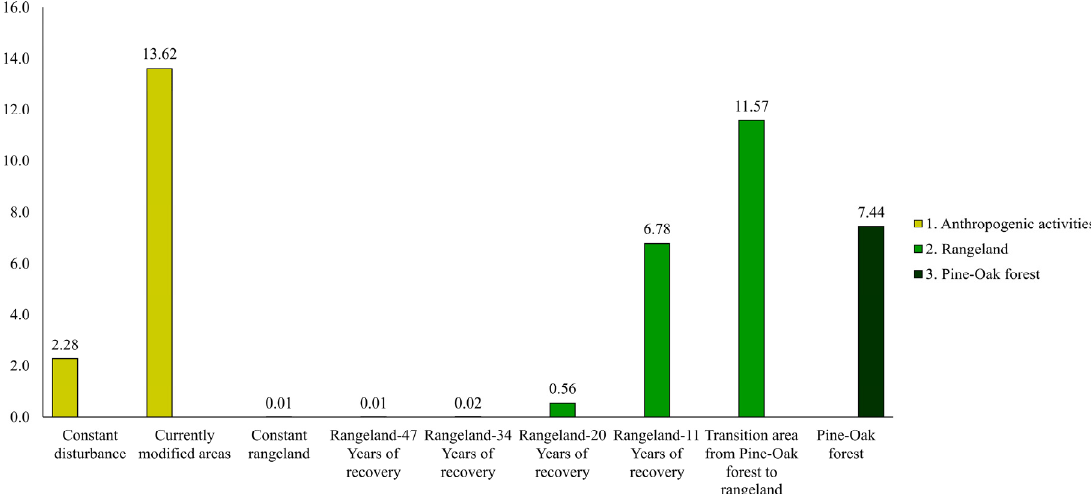
Figure 17. Represented area (km 2 ) for each category of land use coverage during the study period, San Vicente, Palmillas, Tamaulipas, Mexico.